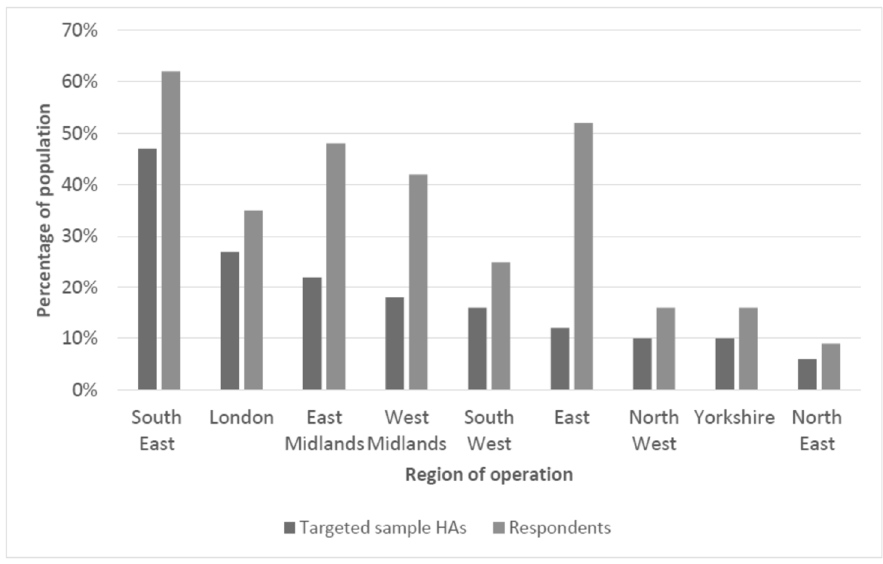
Figure 3. Comparison of the distribution of operational regions of the targeted sample, and those who responded.